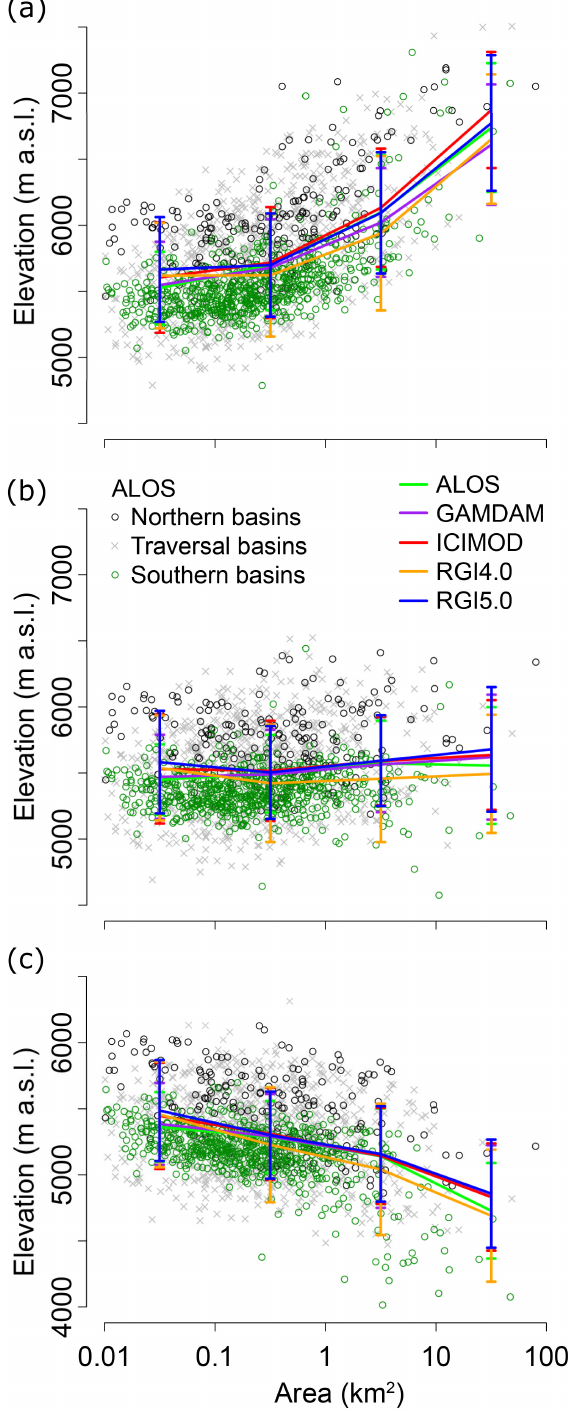
Figure 10. Glacier (a) maximum, (b) median, and (c) minimum el- evations in the ALOS inventory plotted against the log-scaled area. Glaciers are categorised as southern, northern, and traversal basins, as described in Fig. 1. Mean (lines) with standard deviation (vertical bars) of all inventories were calculated in four size